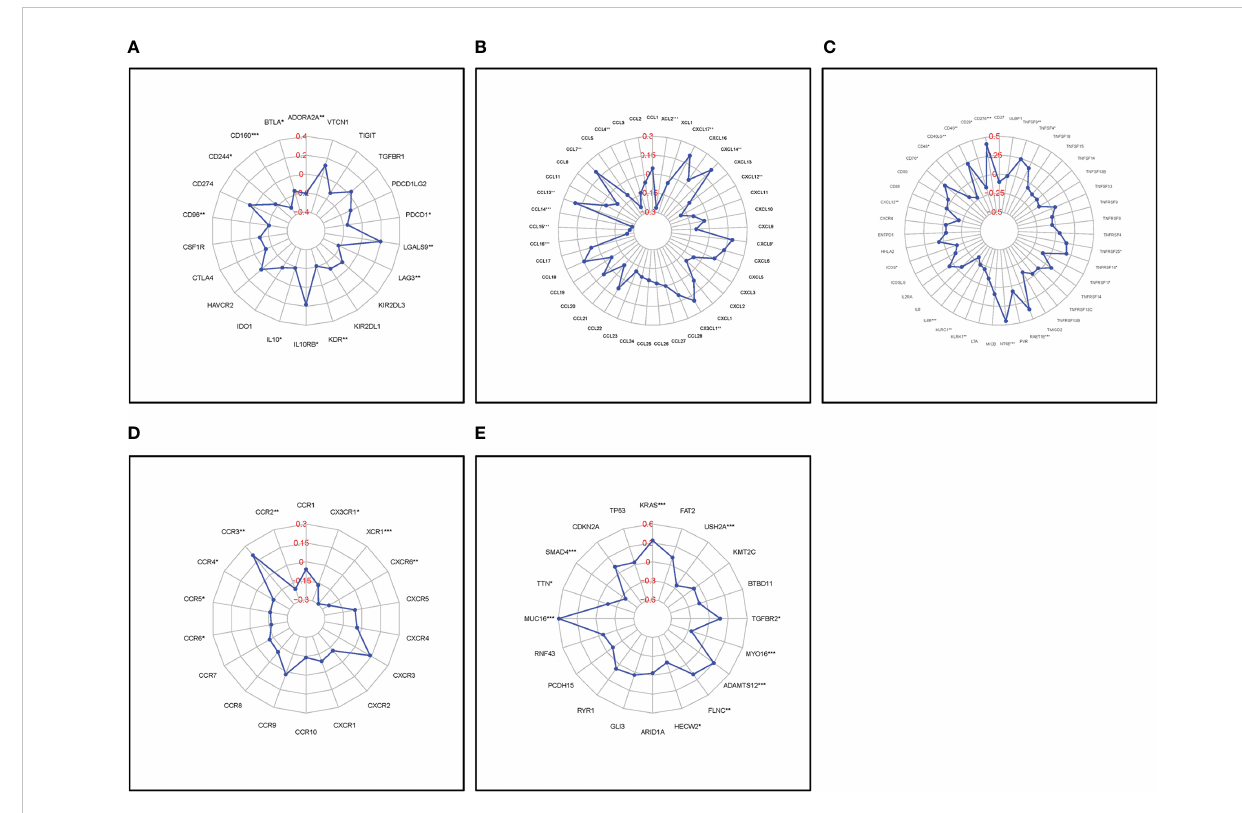
FIGURE 7 Correlation of FAM83A expression with immune-related biomarkers and common mutation genes: (A) Immunostimulatory factors. (B) Immunoinhibitory factors. (C) Chemokines. (D) Chemokine receptors. (E) Mutation genes. Red numbers are considered correlation coef fi